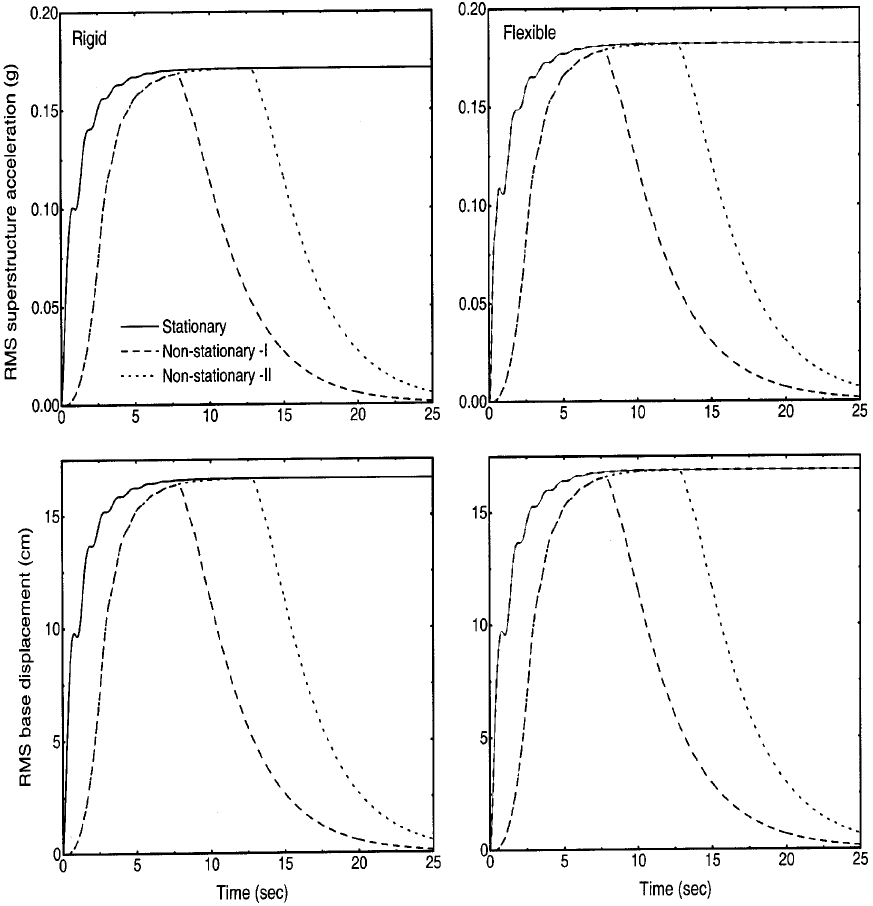
Fig. 4. Time variation of the RMS superstructure acceleration and base displacement of the structure isolated by the LRB system ( T s = 0 . 5 sec, T = 2 sec and ξ = 0 . 1 b b